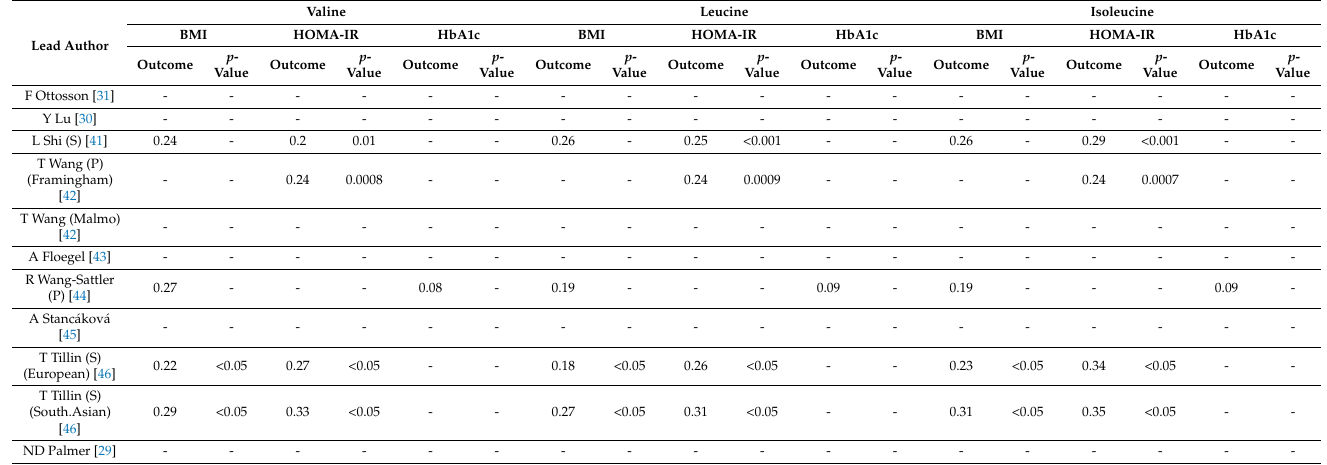
S = Spearmans correlation test, P = Pearsons correlation test, BMI = body mass